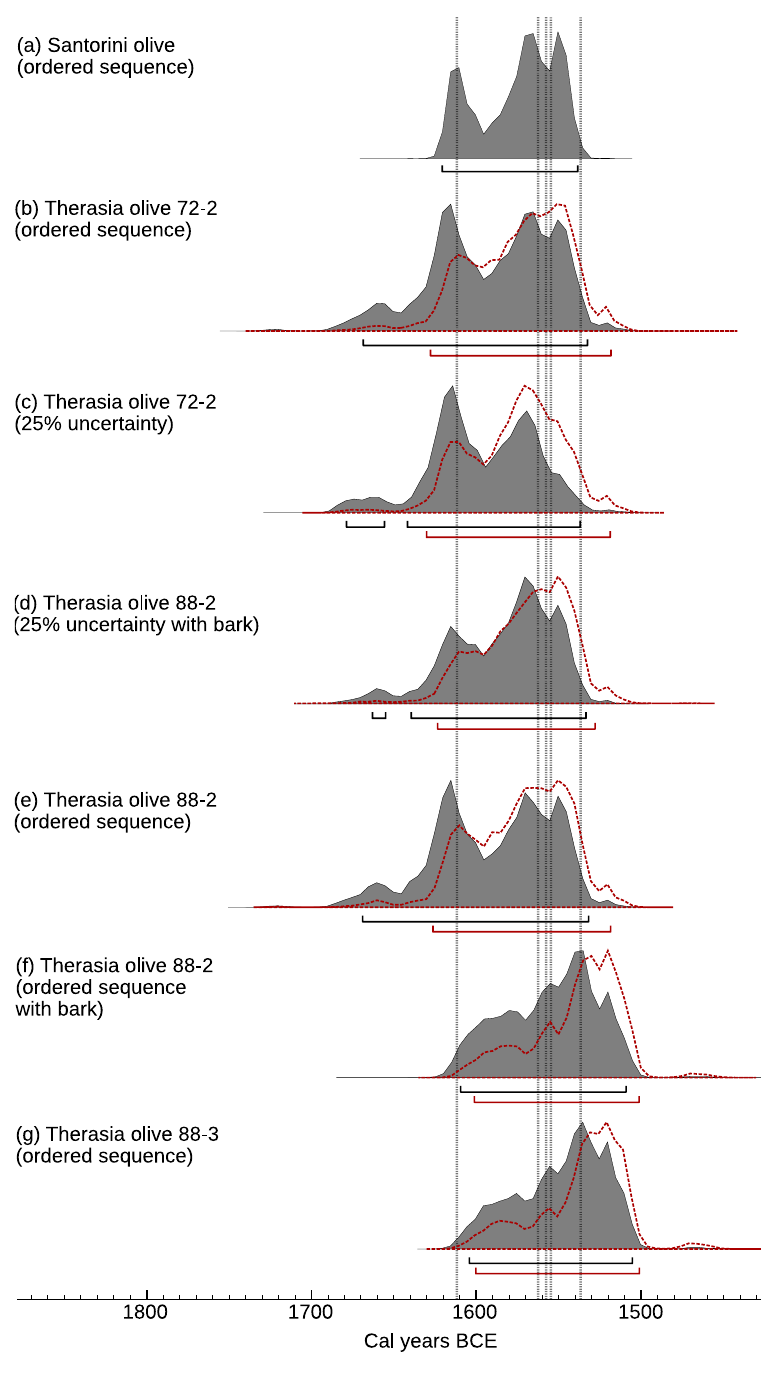
Figure 5. Calibrated dating possibilities for the separate stems of the Therasia olive compared with the Santorini olive ( a ), modelled as a simple ordered sequence (see 12 ) relative to IntCal20 16 using Oxcal 18 v4.4.4. 72-2 ( b , c ) and 88-2 ( d , e ) had the clearest growth boundaries so are shown as both an ordered sequence and a V-sequence at 25% uncertainty. 88-2 had an intact outer-most edge with bark which was also dated and is included in ( d ) and ( f ). 88-3, the small shoot is shown as ( g ), noting that the band count between samples in this case was very few. The changes in probability distribution using the juniper-based offset correction are shown with a red dotted outline. Grey vertical lines indicate current key volcanic sulfate layers in the Greenland ice 31